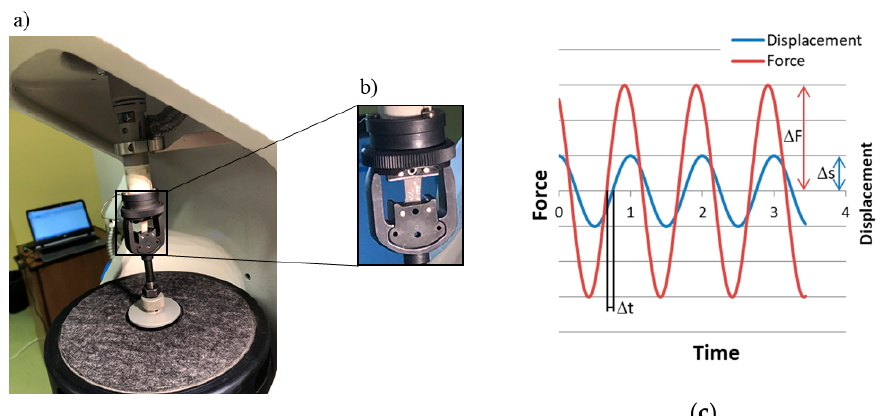
Figure 2. Mechanical testing: ( a ) the test machine; ( b ) a fragment mounted between clamps; ( c ) exemplary force and displacement recording.